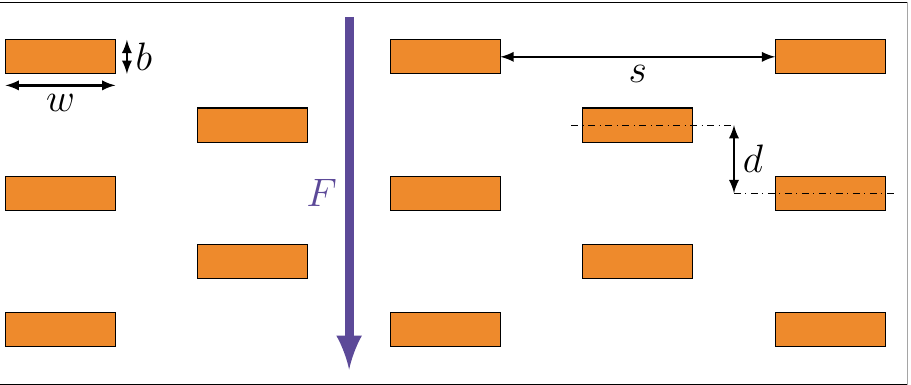
Figure 2. Schematic diagram for fillers in a regular arrangement and important filler parameters (filler width w , filler thickness (breadth) b , filler row distance d , slit distance s , and permeation flow F (main direction of